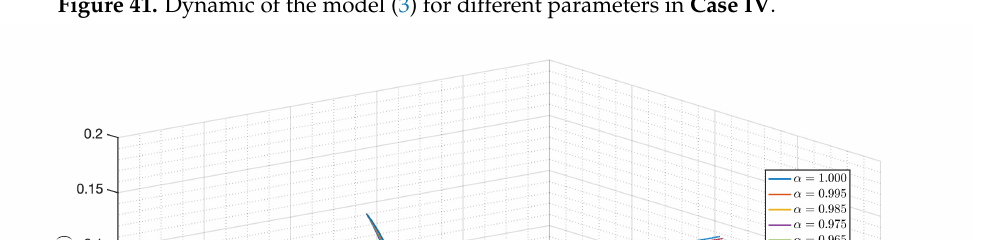
Figure 41. Dynamic of the model (3) for different parameters in Case IV .